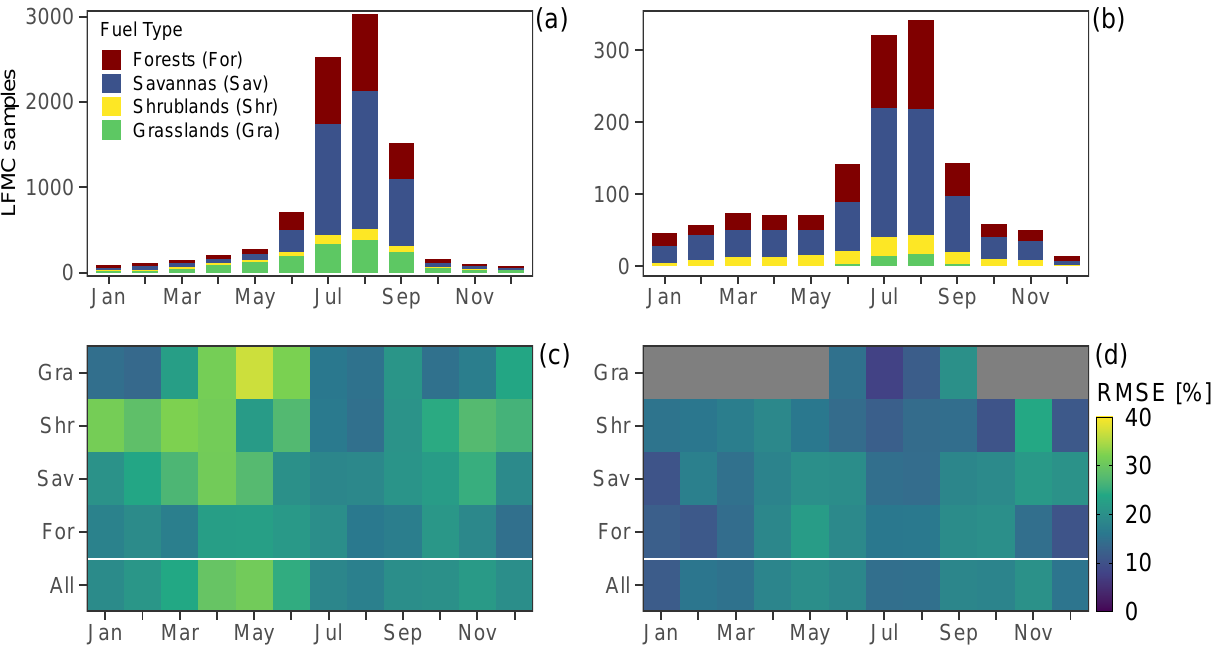
Figure 5. Number of testing samples and RMSE from CAL ( a , c ) and EXT ( b , d ) by vegetation type and month of the year. Gray cells in c and d indicate no data available. The IGBP classes from MCD12Q1 were aggregated by the vegetation functional type to which they